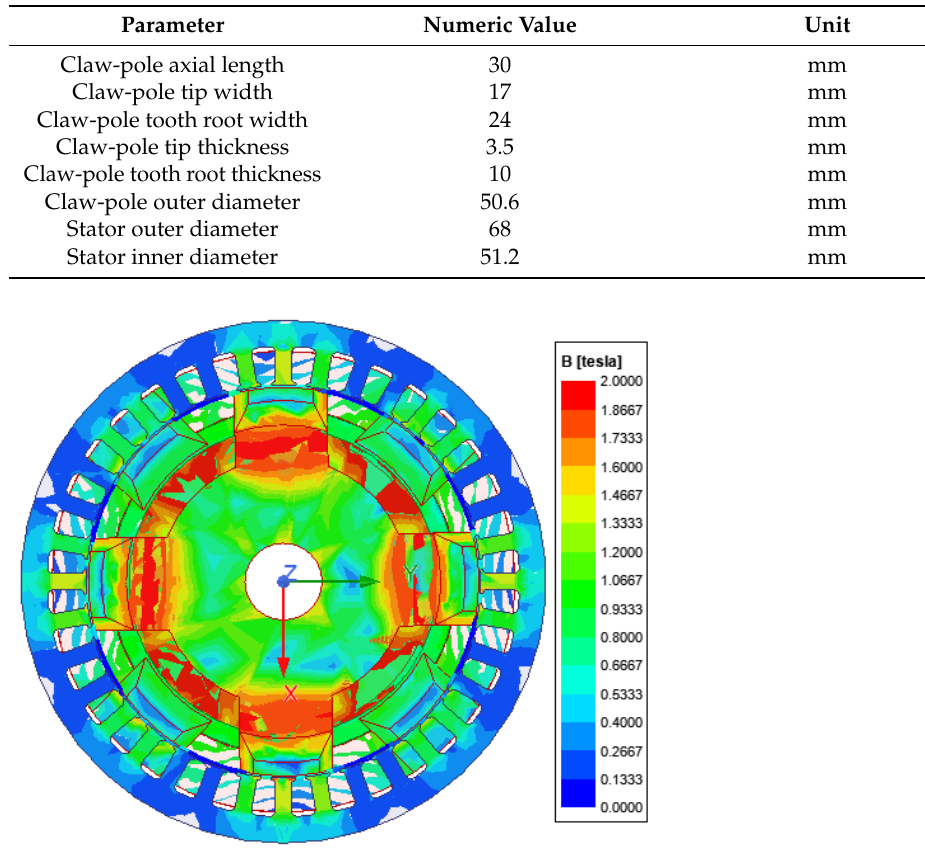
Figure 6. Magnetic density distribution of air gap at the root of the claw pole. It is necessary to show the distribution of the air gap more clearly, so the magnetic flux density cloud map from the outer diameter of the claw pole to the inner diameter of the stator in the axial middle position of the claw pole is shown in Figure 7. Moreover, the magnetic flux density cloud map from the root of the claw to the tip of the claw in the radial middle position of the air gap is shown in Figure 8. From these figures, it can be seen that the flux density at the claw root is larger than that at the claw tip under the same air gap radius. Moreover, at the same distance from the claw root, the smaller the air gap radius is, the largest flux density is. 050100150200250300 -1.5